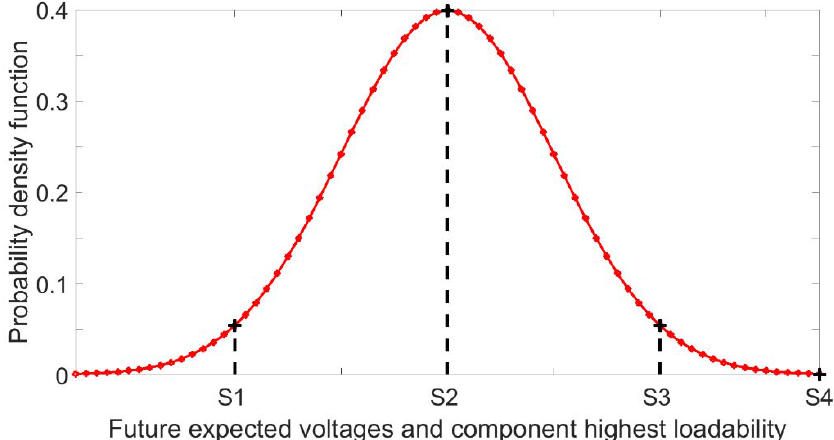
Figure 3. The epistemic PDF shows the expected future probability distribution with the levels of planning for S1, S2, S3 and S4.